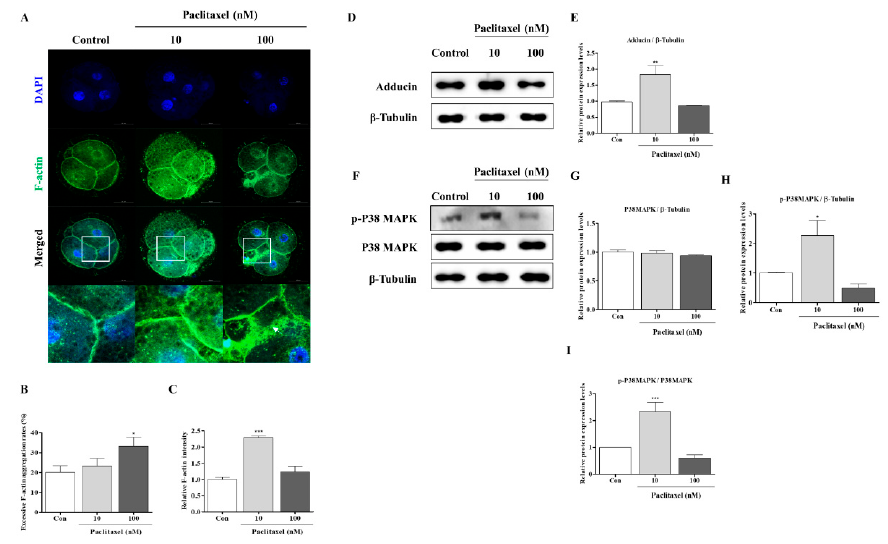
Figure 4. Changes of adhesive junction F-actin, P38 MAPK, and adducin protein levels in paclitaxel exposed porcine embryos at the cleavage stage. ( A – C ) Confirmation of adhesive junction F-actin expression by diverse paclitaxel exposure (10 and 100 nM) during the cleaved embryo stage in pigs. Fluorescence expression of F-actin (green) and DAPI (blue) in cleaved embryos treated with paclitaxel after IVC. Scale bar = 50 µ m. ( D , E ) The protein level of adducin as an actin-binding protein in 10 and 100 nM paclitaxel exposed embryos. ( F – I ) Western blotting results of the P38 MAPK signal (p-P38 and P38) proteins in 10 and 100 nM paclitaxel treated embryos. Relative folds of protein levels were obtained by normalizing the signals to β -tubulin. Blots were probed with phosphorylation- specific antibodies for P38 MAPK and total P38 MAPK. Densitometric analysis was performed by normalizing phosphorylated P38 MAPK to total levels of P38 MAPK. Histograms represent the values of densitometry analysis obtained using ImageJ software. Data in the bar graph are presented as the means ± SD of three independent experiments (per 70 cleaved embryos). Differences were considered significant at * p < 0.05, ** p < 0.01, *** p < 0.001 compared to the control group.